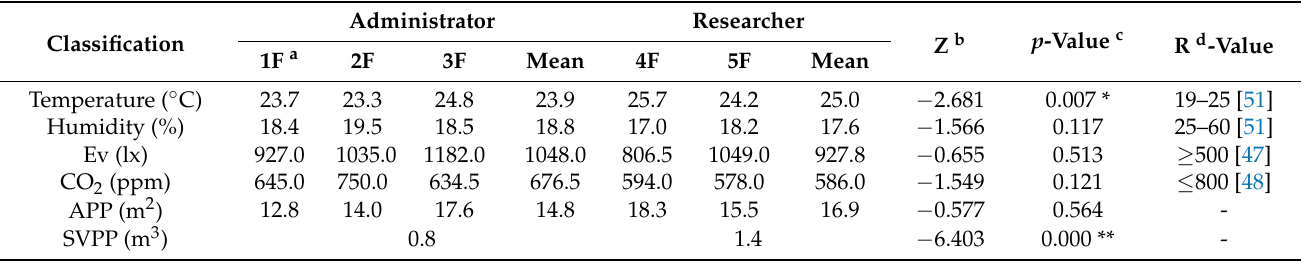
Table 4. Comparison of quantitative measurements between the administrative and research groups, analyzed using the Mann–Whitney U